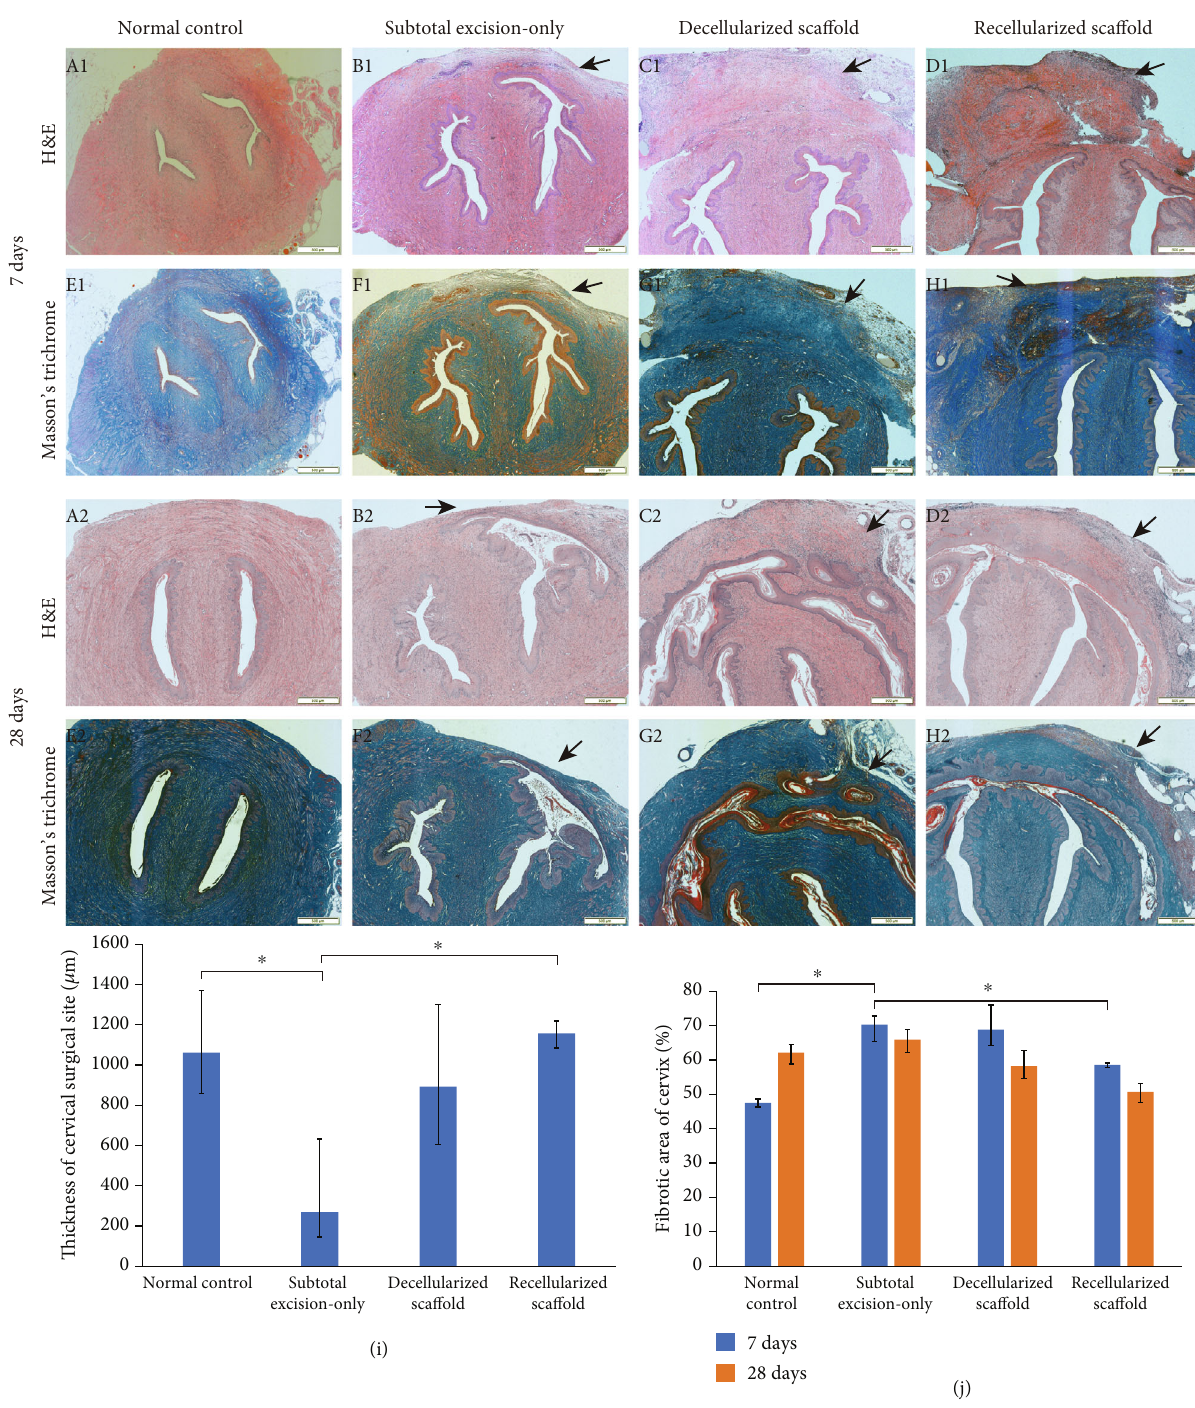
Figure 5: Histological evaluation of reconstruction of partial uterine cervical defect in rat. Histological images of cross-sections of rat uterine cervix from the subtotal excision-only group, decellularized sca ff old group, and recellularized sca ff old group were shown at 7 days (A1-H1) and 28 days (A2-H2) postsurgery. (a – d) are for H&E staining, and (e – h) are for Masson ’ s trichrome staining. Black arrows indicate the surgical sites of each group. Scale bars represent 500 μ m. Statistical analysis of the thickness of cervical surgical site (i) fi nds that the cervical surgical site in both sca ff old groups was thicker than the subtotal excision-only group and was similar to the normal control group. Masson staining illustrated collagen fi bers as blue fi bers and was used to detect cervical fi brosis (j). The proportion of fi brotic area of the recellularized sca ff old group and normal control group was lower than that of the subtotal excision-only group. There were no signi fi cant di ff erences in fi brosis between 7 days and 28 days after surgery in all groups. Data are presented as mean ± SEM . ∗ P < 0 : 05